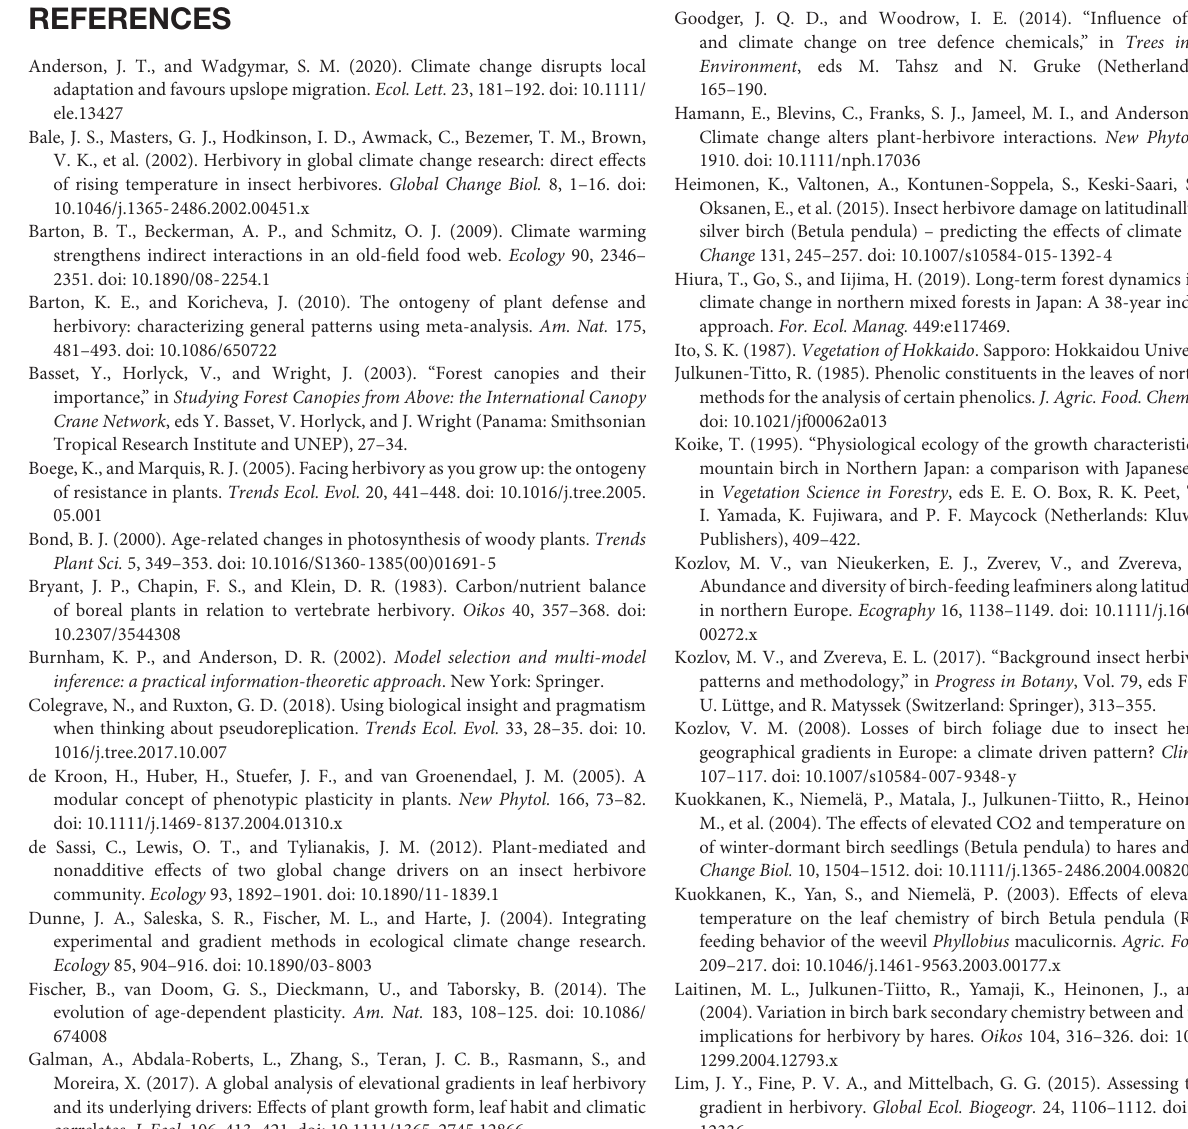
Supplementary Table 1 | Summary of the model selection procedure for the variation in herbivory rate in (A) the elevational-gradient study and (B) the warming experiment. The most likely multivariate models ( (cid:49) AIC < 2) are shown. The Log-likelihood value (LL), difference of the AIC between the current and the